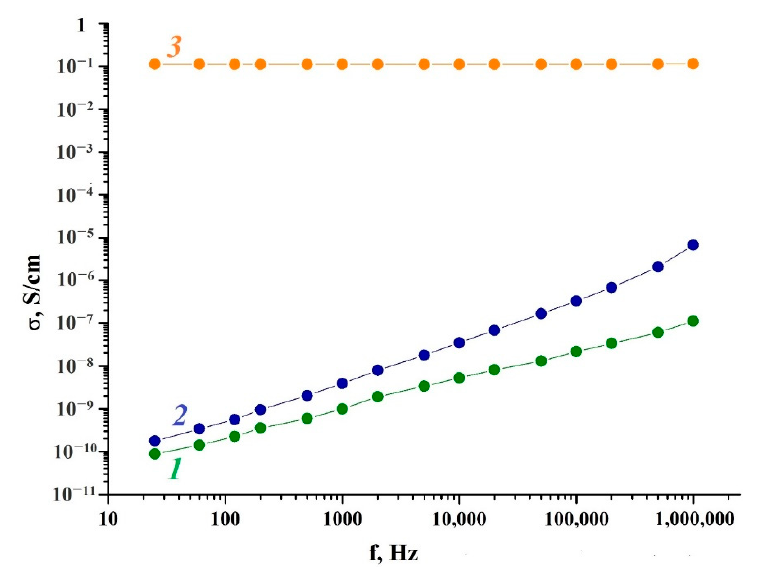
Figure 14. Dependence of conductivity on the frequency for P-N-PAA (1) , Fe 3 O 4 /P-N-PAA (2) and MNP/P-N-PAA, obtained at 800 ◦ C (3) .